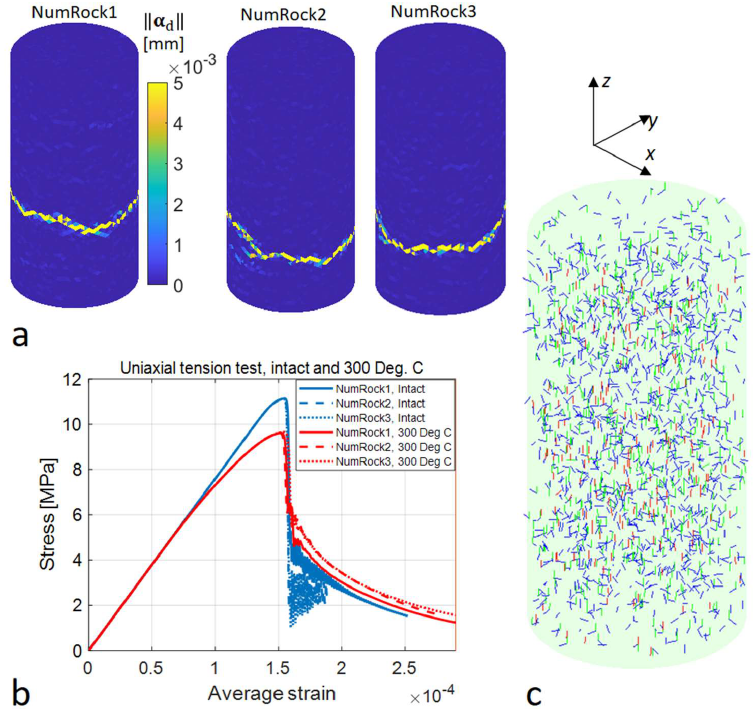
Figure 6. Simulation results for uniaxial tension test (heated 300 ◦ C): ( a ) Failure models represented by crack opening magnitudes; ( b ) Average stress-strain curves; ( c ) Crack normals for NumRock1 (every 100th shown, blue = thermal cracks, red = tensile cracks, green = new tensile cracks in elements with a thermal crack).